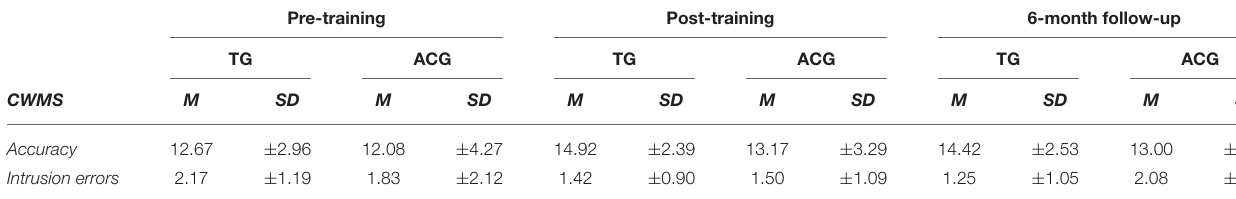
TABLE 2 | Means ( M ) and standard deviations ( ± SD ) of the criterion task (CWMS) and CWMS intrusion errors by group and assessment session. Pre-training Post-training